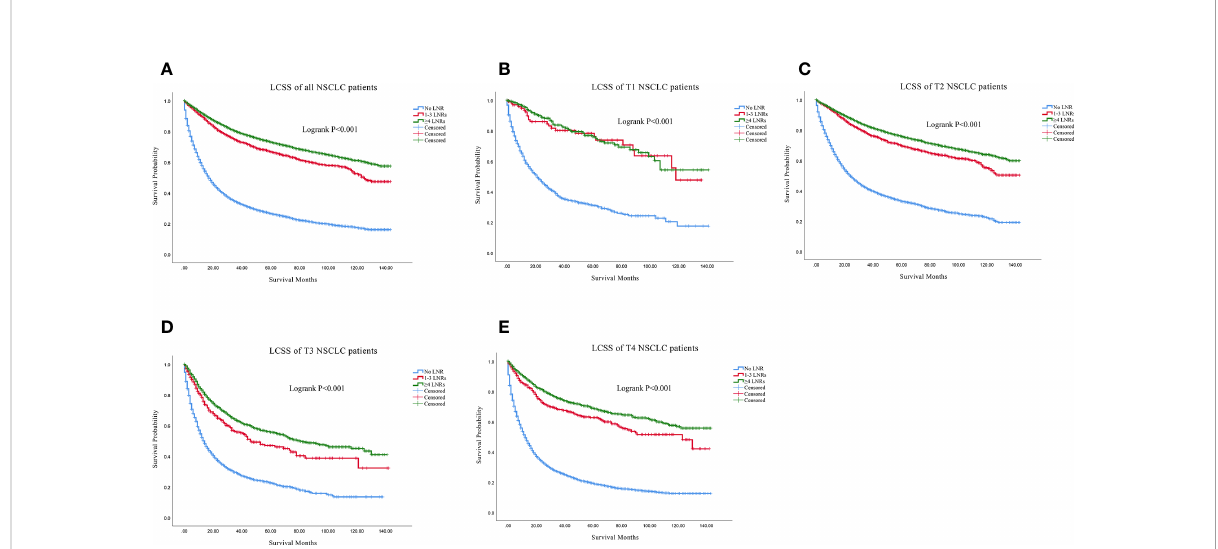
FIGURE 3 Comparison of LCSS in no LNR group, 1-3 LNR group and ≥ 4 LNRs group for N0 NSCLC patients. (A) Comparison in all the N0 NSCLC patients; (B) Comparison in T1 N0 NSCLC patients; (C) Comparison in T2 N0 NSCLC patients; (D) Comparison in T3 N0 NSCLC patients; (E) Comparison in T4 N0 NSCLC patients. NSCLC, non-small cell lung cancer; LCSS, lung cancer speci fi c survival; LNRs, lymph nodes